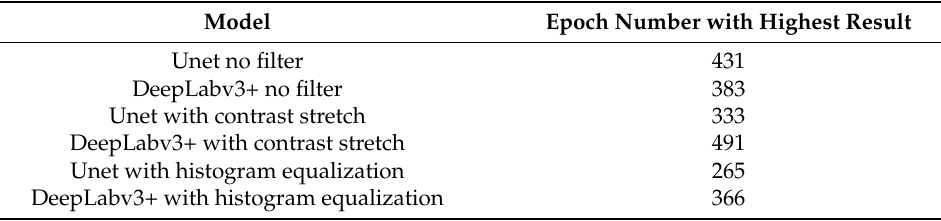
Table 1. The required epoch number for each model that obtains its highest mean IoU score. Model Epoch Number with Highest Result Unet no filter 431 DeepLabv3+ no filter 383 Unet with contrast stretch 333 DeepLabv3+ with contrast stretch 491 Unet with histogram equalization 265 DeepLabv3+ with histogram equalization 366 Loss Function and Accuracy Metric